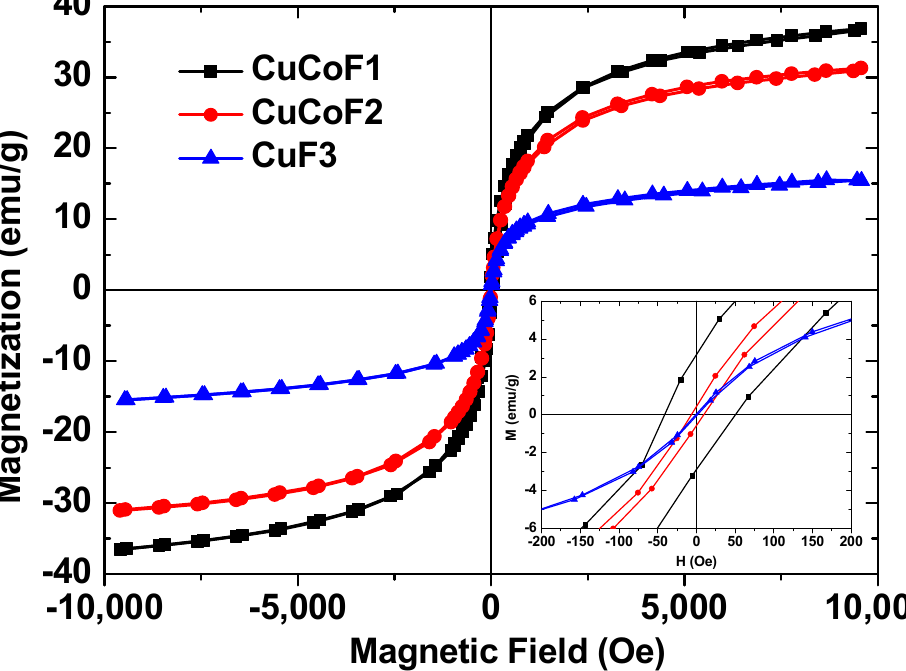
Figure 6. Magnetic hysteresis curves of prepared CuCoF1, CuCoF2, and CuF3 spinel ferrite nano ‐ particles.